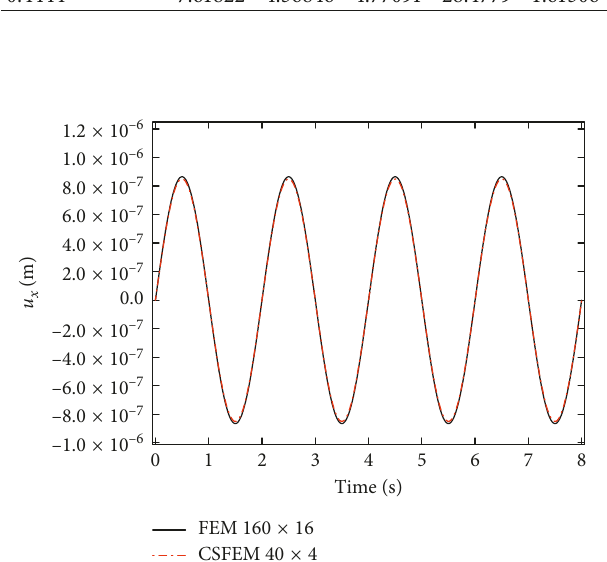
Figure 18: The variation of the electrical potential V at point A x at point A with with respect to time.